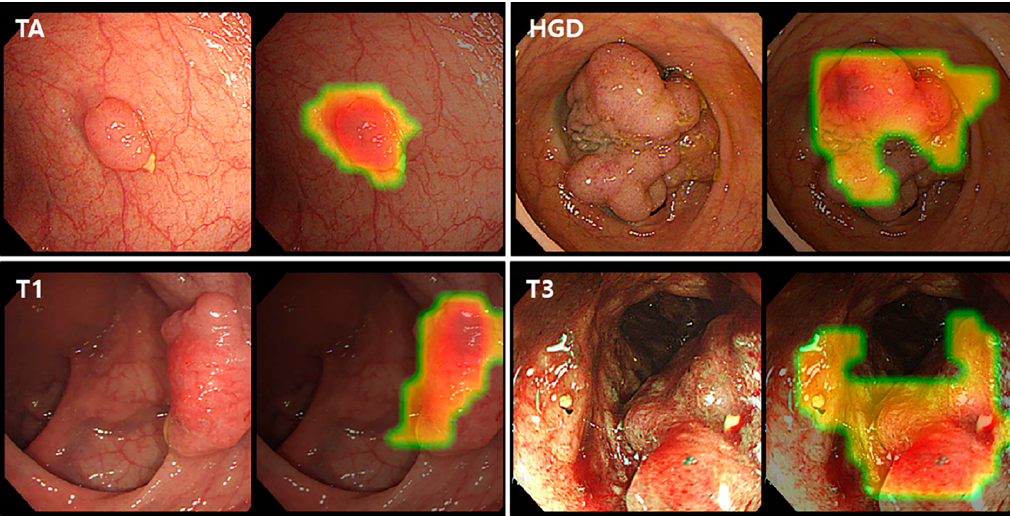
Figure 5. Class activation maps of the binary classification model detecting neoplasms (TA or higher) for several colorectal lesions. TA, tubular adenoma; HGD, high-grade dysplasia.